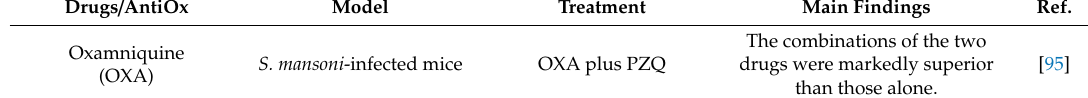
Table 1. Drugs and antioxidants evaluated against schistosomes and opisthorchiids. Drugs /